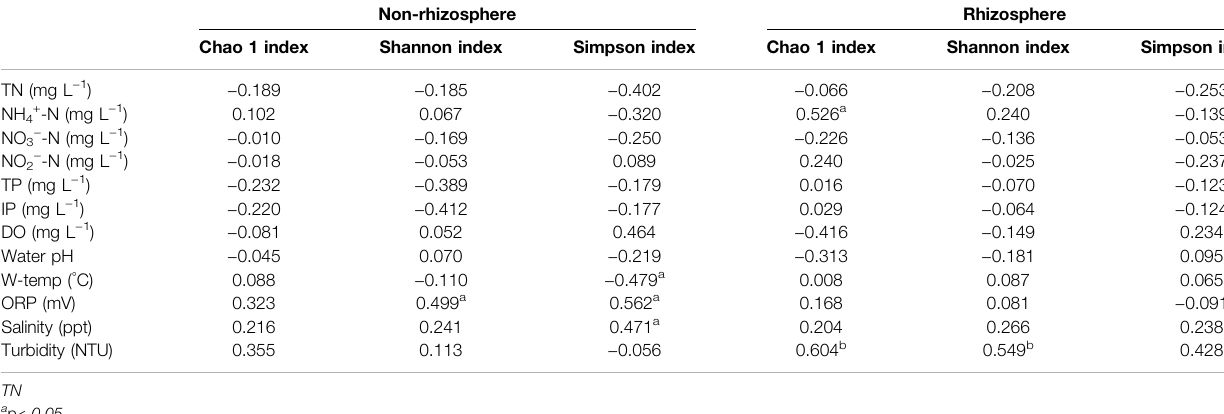
TABLE 1 | Spearman ’ s correlation coef fi cients between sediment microbial diversity and water quality.